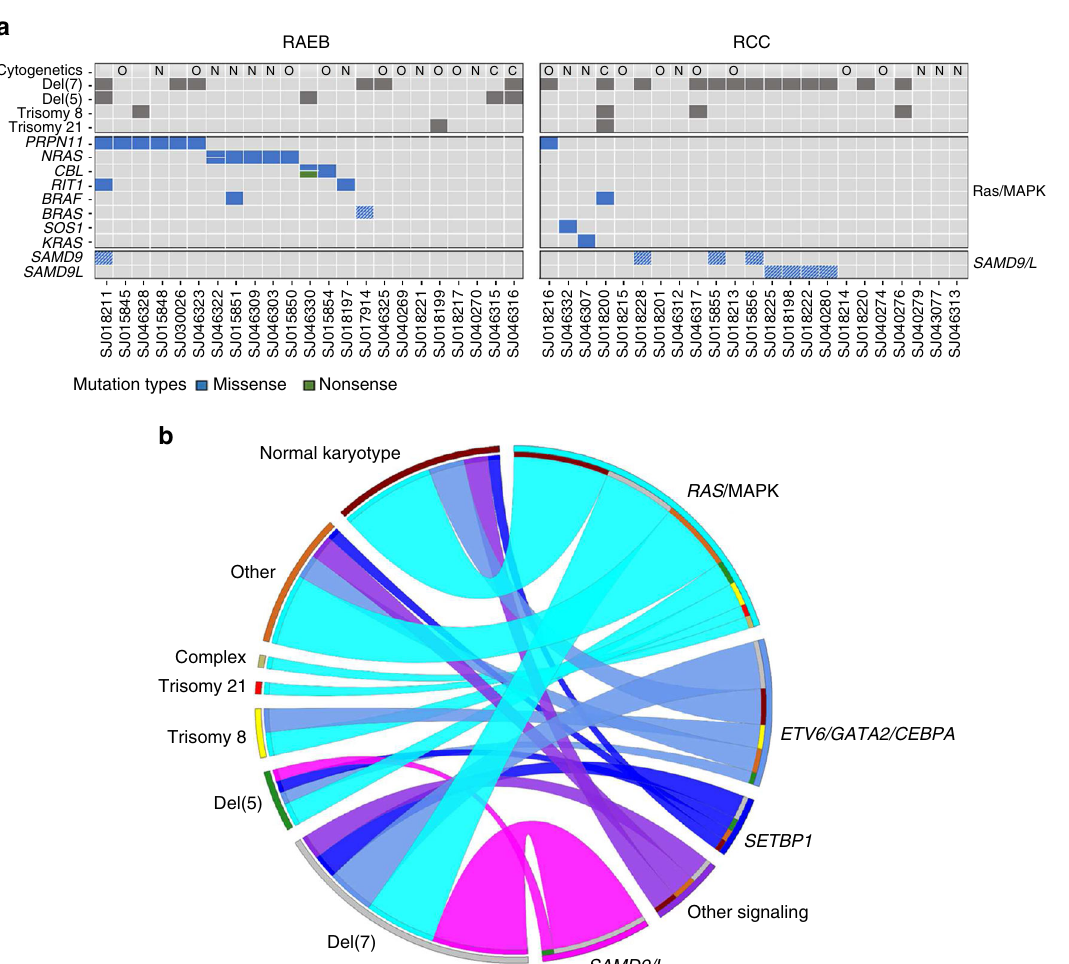
Fig. 6 The genomic landscape of pediatric primary MDS. a Heat map indicating primary MDS patients, subdivided into RCC and RAEB categories, with somatic mutations, germline variants (cells with hatched lines), and transcript fusions. Ras/MAPK mutations are enriched in the RAEB subgroup (65% vs 17%, p = 0.002, Fisher ’ s exact test) b Ribbon plot showing associations between cytogenetic abnormalities and recurrent mutations in myeloid neoplasms. Data from WES and targeted amplicon sequencing of the primary MDS cohort ( n = 46) was used to build the plot. Associations between a cytogenetic abnormality and a mutation are connected by a ribbon, the width of which is proportional to the frequency of that